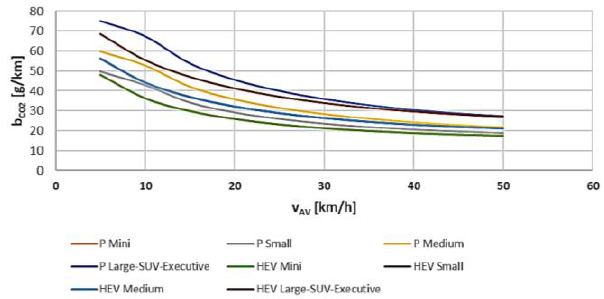
Fig. 10. CO 2 emission from PCs for fuel type depending on average Fig. 6. CO 2 emission from petrol PCs for vehicle depending on average speed